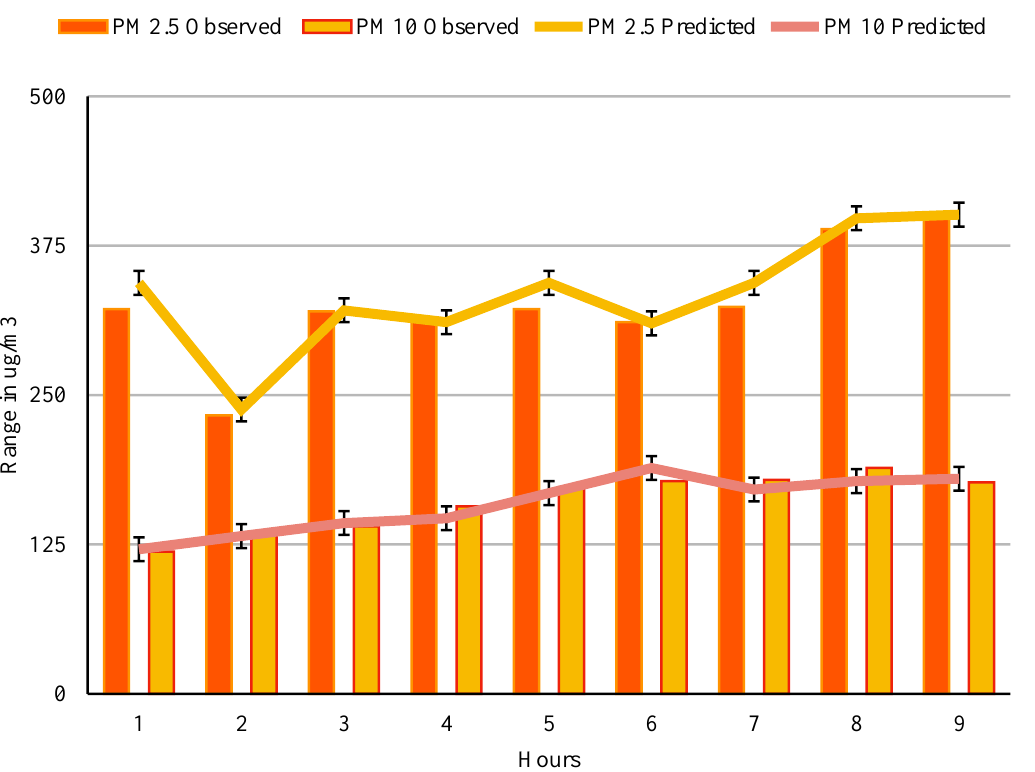
Figure 7. Comparison of predicted values toward the observed values, along with positive and negative error bars for 9 h of prediction.